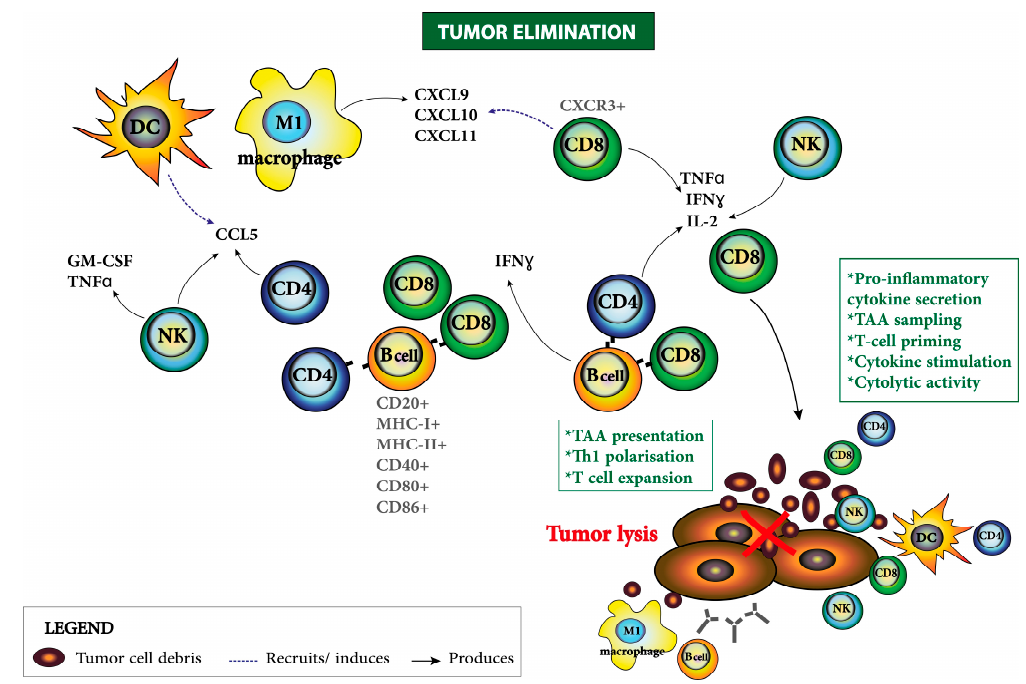
Figure 1. Antitumoral responses in the EOC TME. Immunogenic cell death induces the release of DAMPs mediating the recruitment of innate cells and APCs. Lympho-attracting chemokines produced by APCs such as macrophages enable the recruitment of CD8+ T cells to the tumor